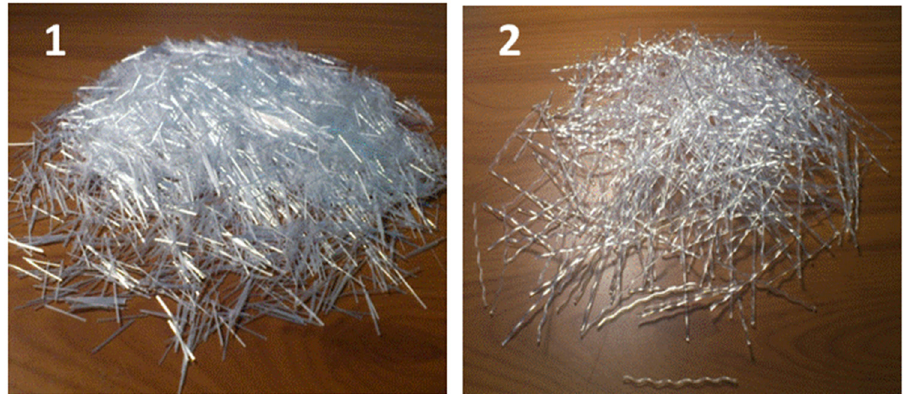
Figure 2: Fibers used in this study: ( 1 ) GF and ( 2 ) PPF.